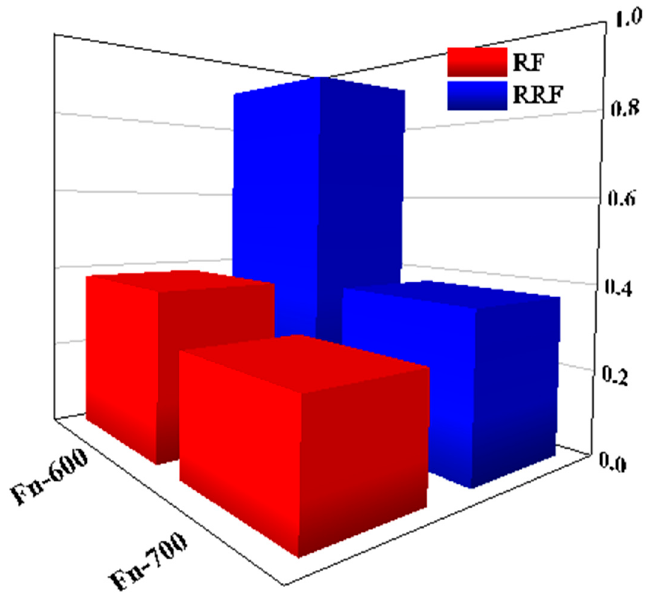
Figure 11. RF and RRF of carbonate core (Fn-600) and sandstone core (Fn-700).